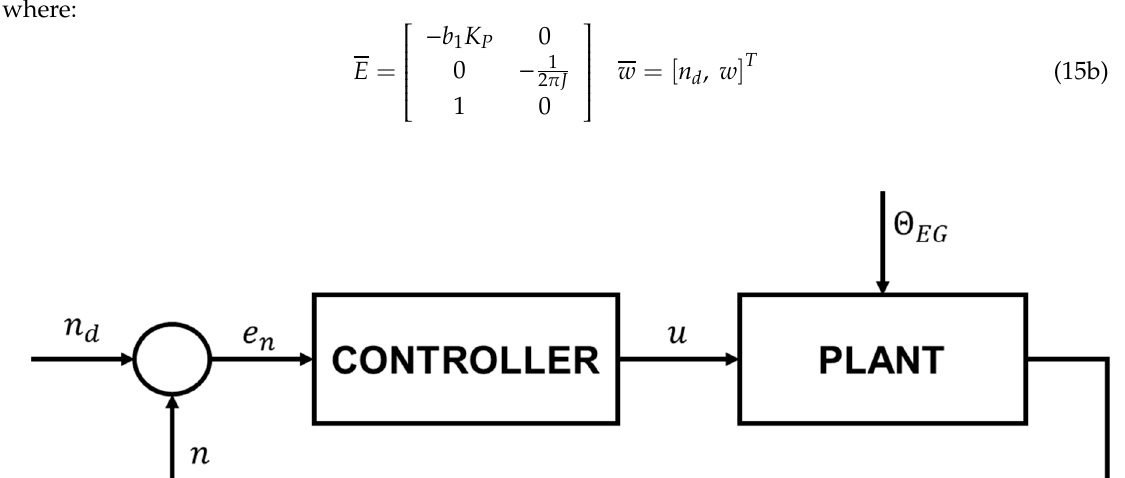
Figure 7. Closed-loop structure.